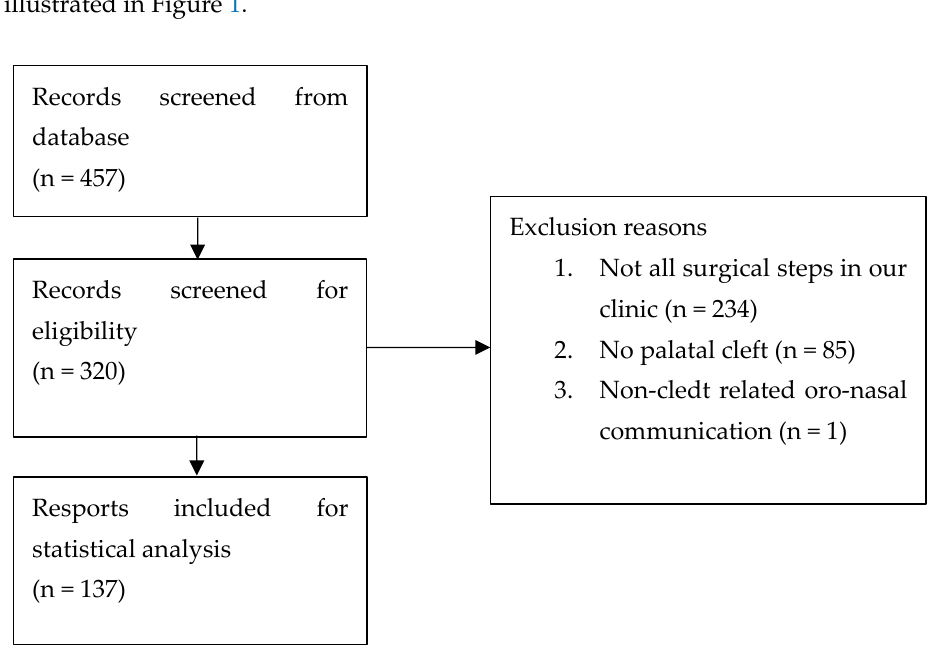
Table 1. Ages of the male and female patients at their primary surgical intervention. Male 0.938 Figure 2. Ages of the male and female patients at their primary surgical intervention. “*”— outli- ers. The prevalence of fistulae found in the studied sample was 29 out of 137 cases, cor- responding to 21.17% (95% CI 15.16 – 28.75%).